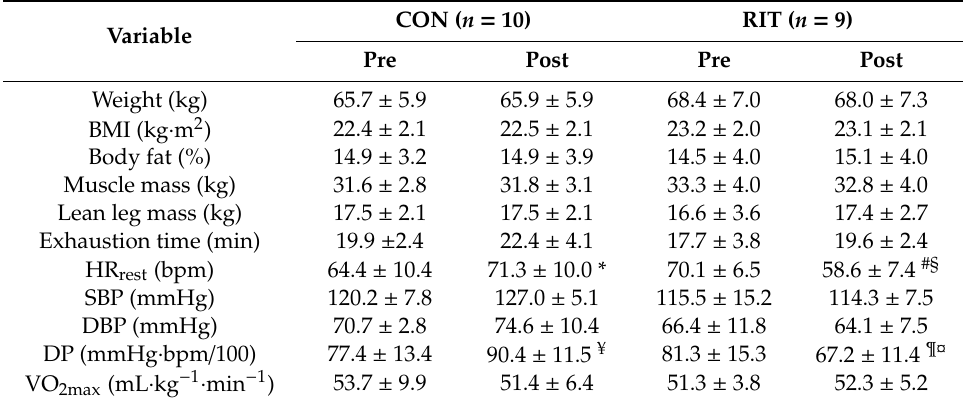
Table 1. Inferential statistics by experimental group and measurement time.